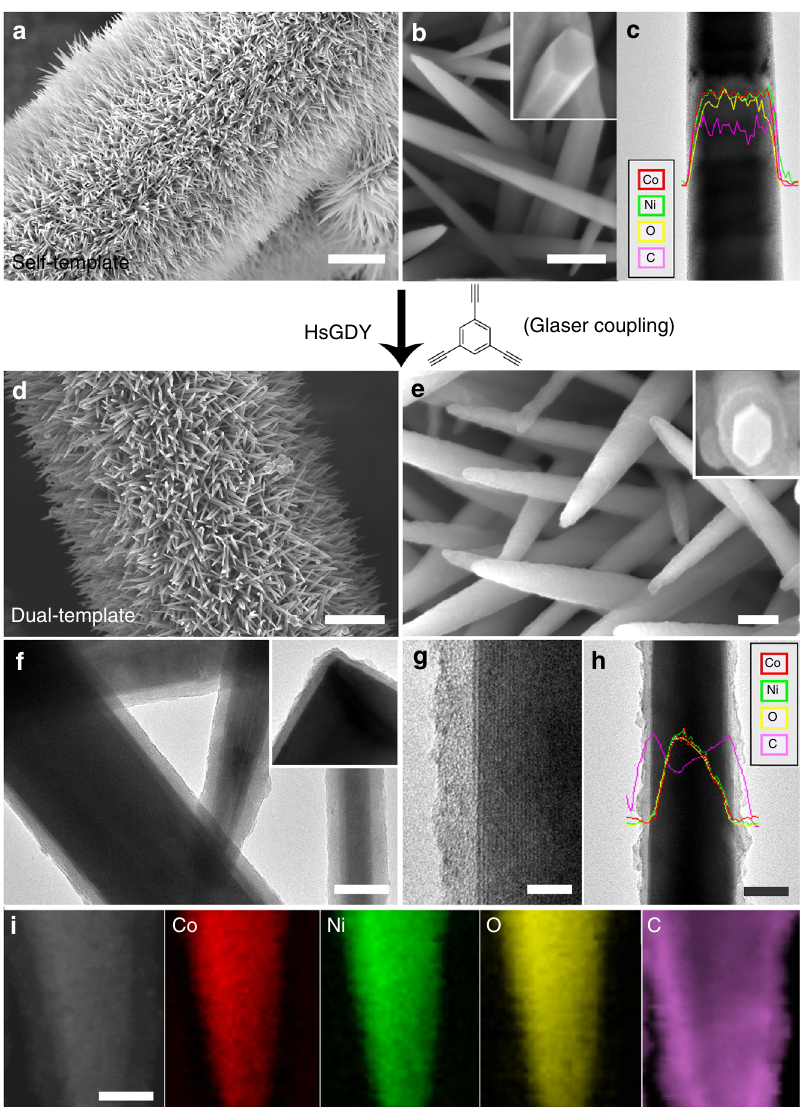
Fig. 2 Scanning electron microscopy and transmission electron microscopy micrographs. a , b Scanning electron microscopy (SEM) images, c Transmission electron microscopy (TEM) image and line-scan electron energy loss spectroscopy (EELS) elemental distributions of the (Ni,Co)(OH) 2 CO 3 (NiCoHC) nanowires arrays. d , e SEM images, f , g TEM images, h line-scan EELS elemental distributions, and i Scanning transmission electron microscopy (STEM)- EELS elemental mapping of the NiCoHC@hydrogen-substituted graphdiyne (HsGDY) nanowires. The insets of b , e , and f are the corresponding SEM images of the cross-sections and TEM image of the corner, respectively, taking from some broken nano fi bres. Scale bars: ( a , d ) 2 μ m, ( b , e ) 200 nm, ( f , h , i ) 50 nm, ( g ) 10